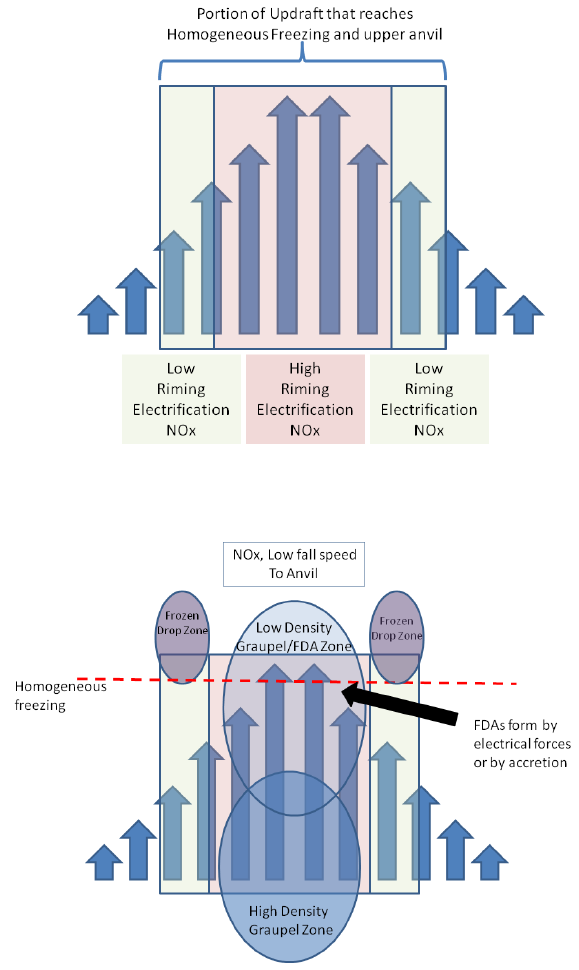
Figure 9. Conceptual model of the 6 and 15 June cases showing processes likely in the main cell (top) and the resulting microphys- ical structure (bottom). See text for more